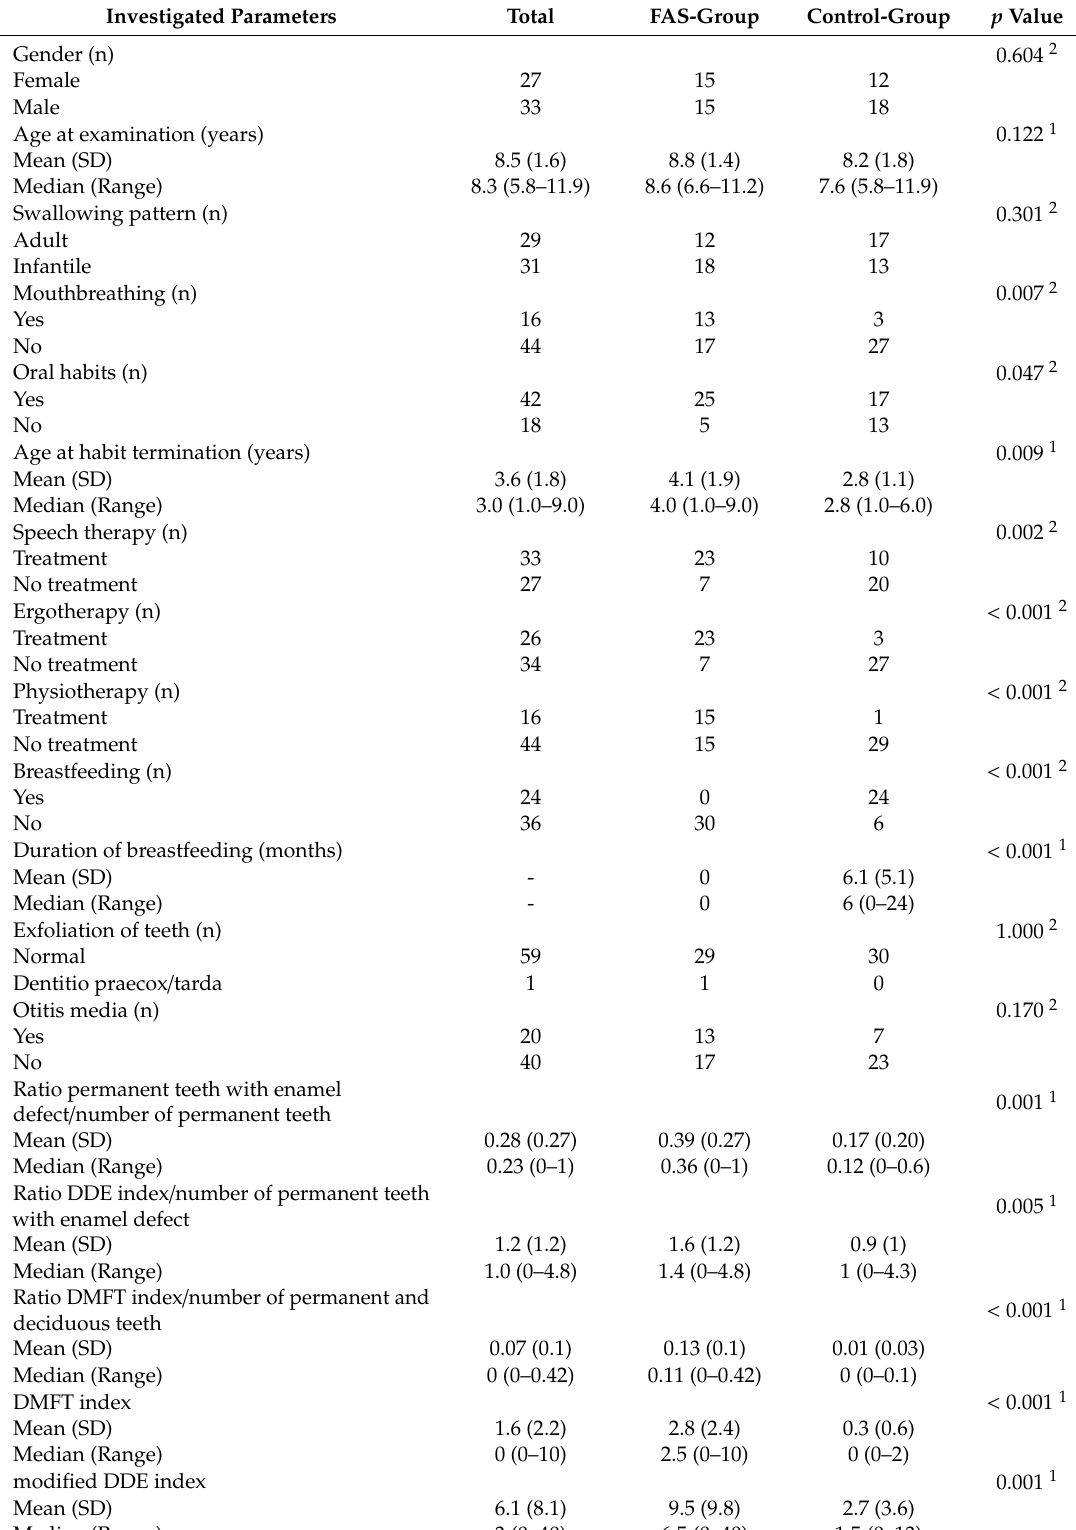
Table 1. Descriptive and analytical statistics for all outcome parameters